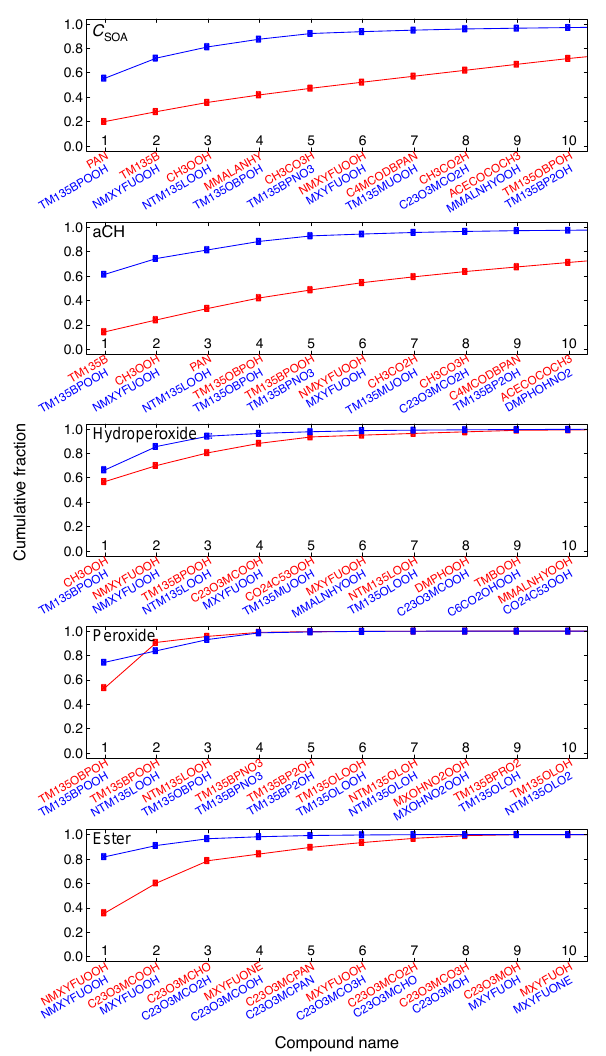
Figure 9. Cumulative contribution (as a fraction of total) of each compound to the overall C SOA mass and abundance of different FGs for the TMB-lNO x simulation. Compounds are arranged in or- der of decreasing contribution (i.e., the first compound contributes most) for each phase. Contributions to the aerosol phase are shown in blue and the gas phase in